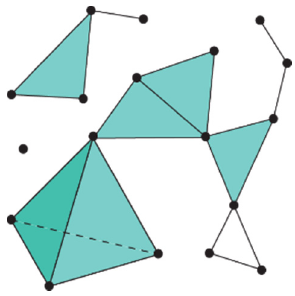
Figure 2. Simplicial Complex.